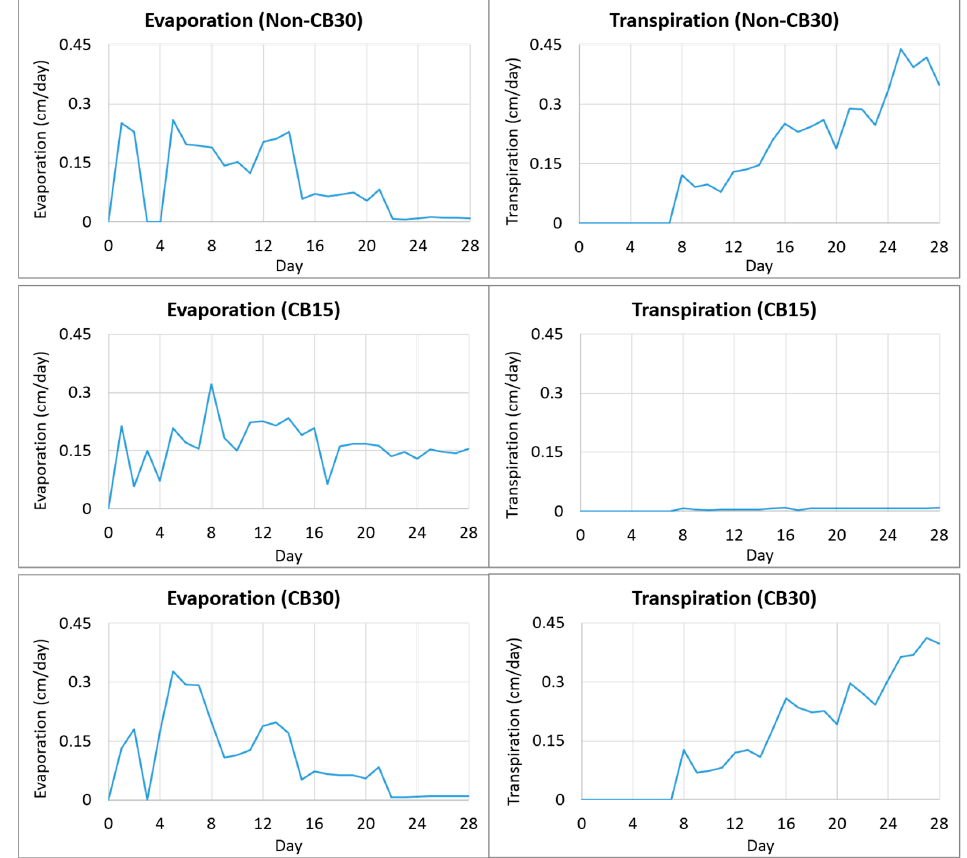
Figure 4. Evaporation and transpiration rates for Non-CB30 ( top ), CB15 ( middle ), and CB30 ( bottom ) adopted from Wongkaew et al. [12] by dividing the actual evapotranspiration rate obtained from Miyake et al. [20] for each simulation.